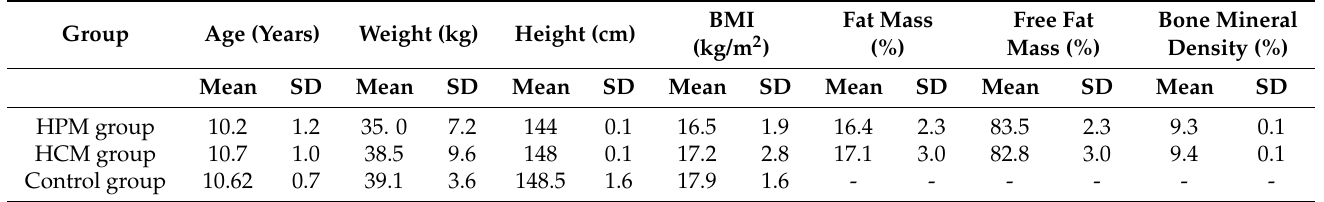
Table 2. Characteristics of the gymnast (both HPM and HCM) and control